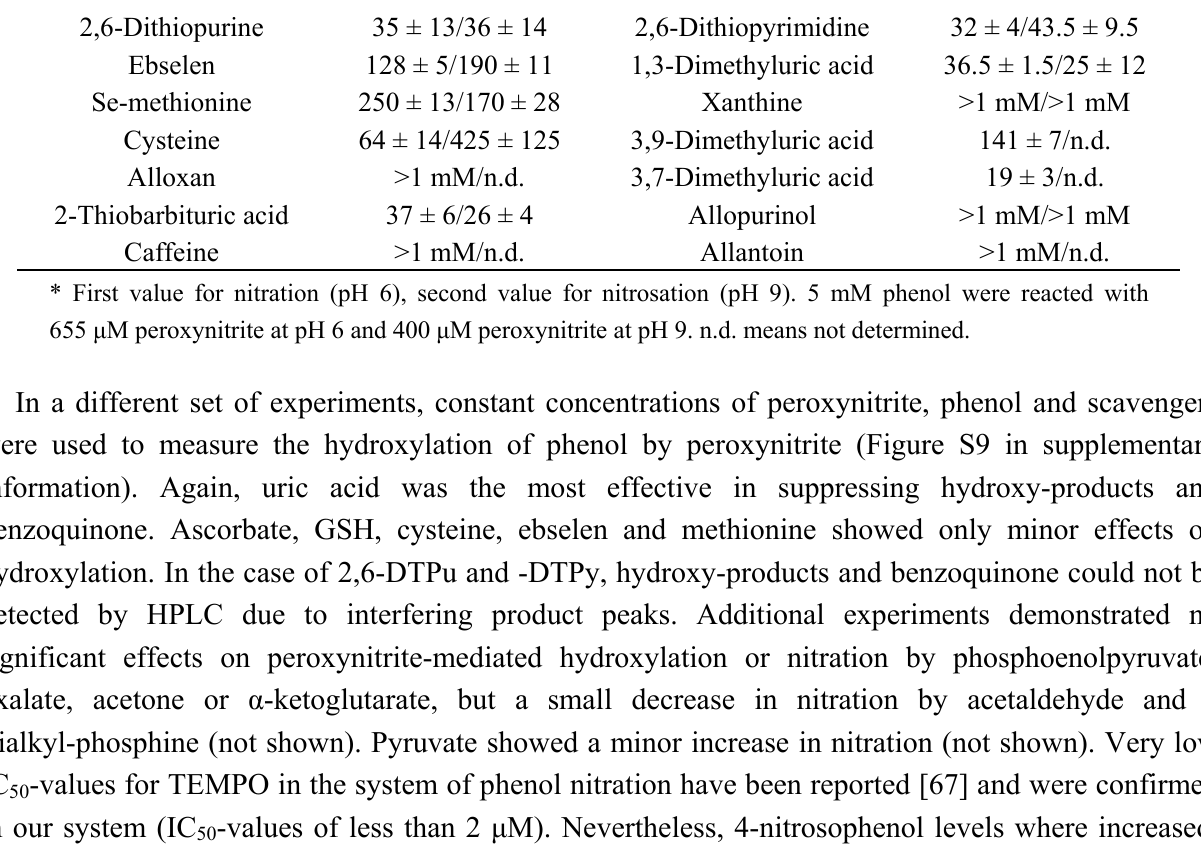
-values) of various compounds for 50